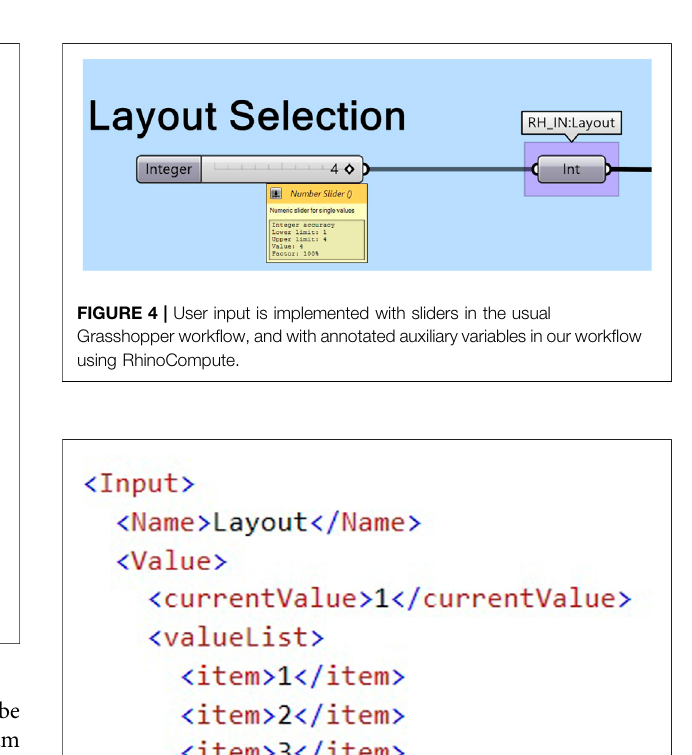
Frontiers in Virtual Reality |